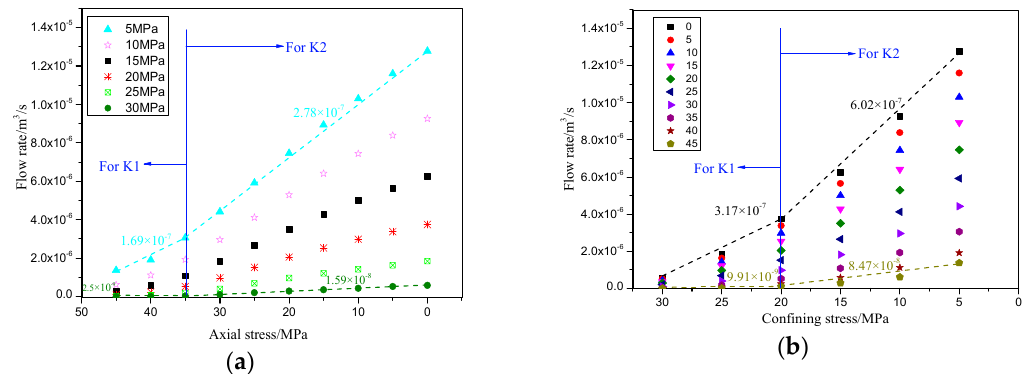
Figure 18. Flow rate change curves with a 60-degree crack: ( a ) variation in flow rate with the axial pressure and ( b ) variation in flow rate with the confining pressure.